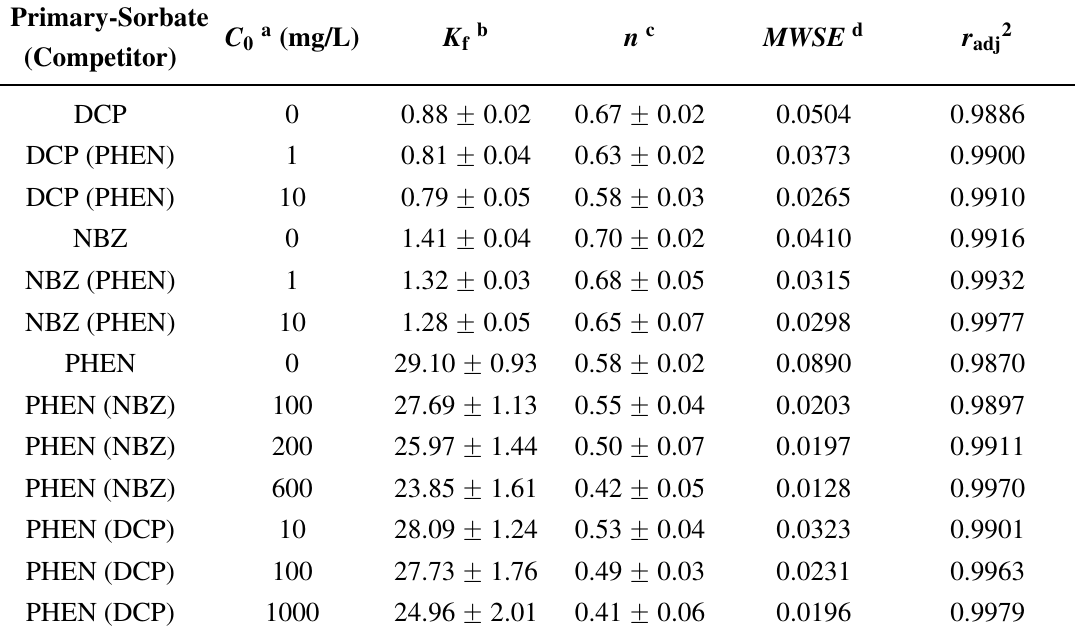
Table 2. Freundlich (FM) model for PHEN and DCP and NBZ in non-competitive adsorption and in competitive adsorption on Hexylene-bridged periodic mesoporous polysilsesquioxanes